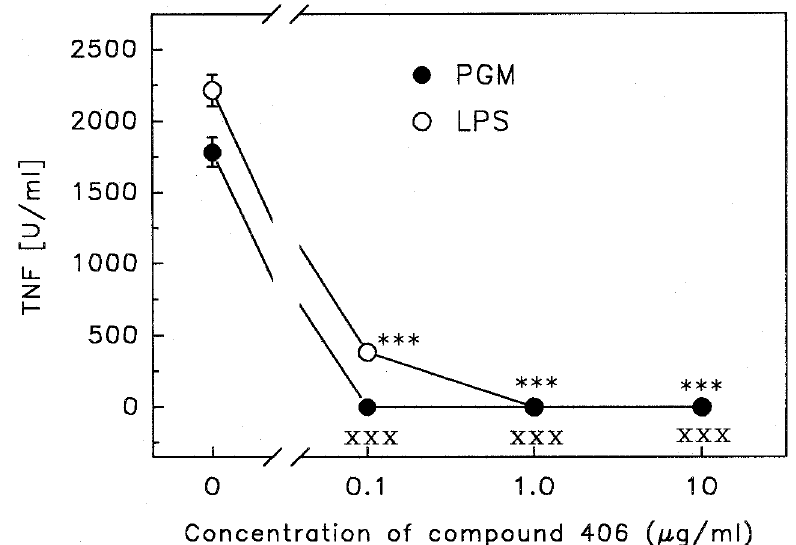
FIG. 3. Inhibition of tumor necrosis factor (TNF) release induced by peptidoglycan monomer (PGM) and lipopolysaccharide (LPS) from mononuclear cells (MNC) by the compound 406. MNC (4 ´ 10 6 /ml) were preincubated with increasing concentrations of compound 406 for 1h at 4°C before stimulation with PGM (30 m g/ml) or LPS (10ng/ml). After 8h of incubation (in the presence of human serum), supernatants were harvested and TNF activity was detected in the bioassay. Results represent the mean of triplicates ± SEM from one of three identical experiments. *** p < 0.001, PGM versus PGM with compound 406; xxx p < 0.001, LPS versus LPS with compound